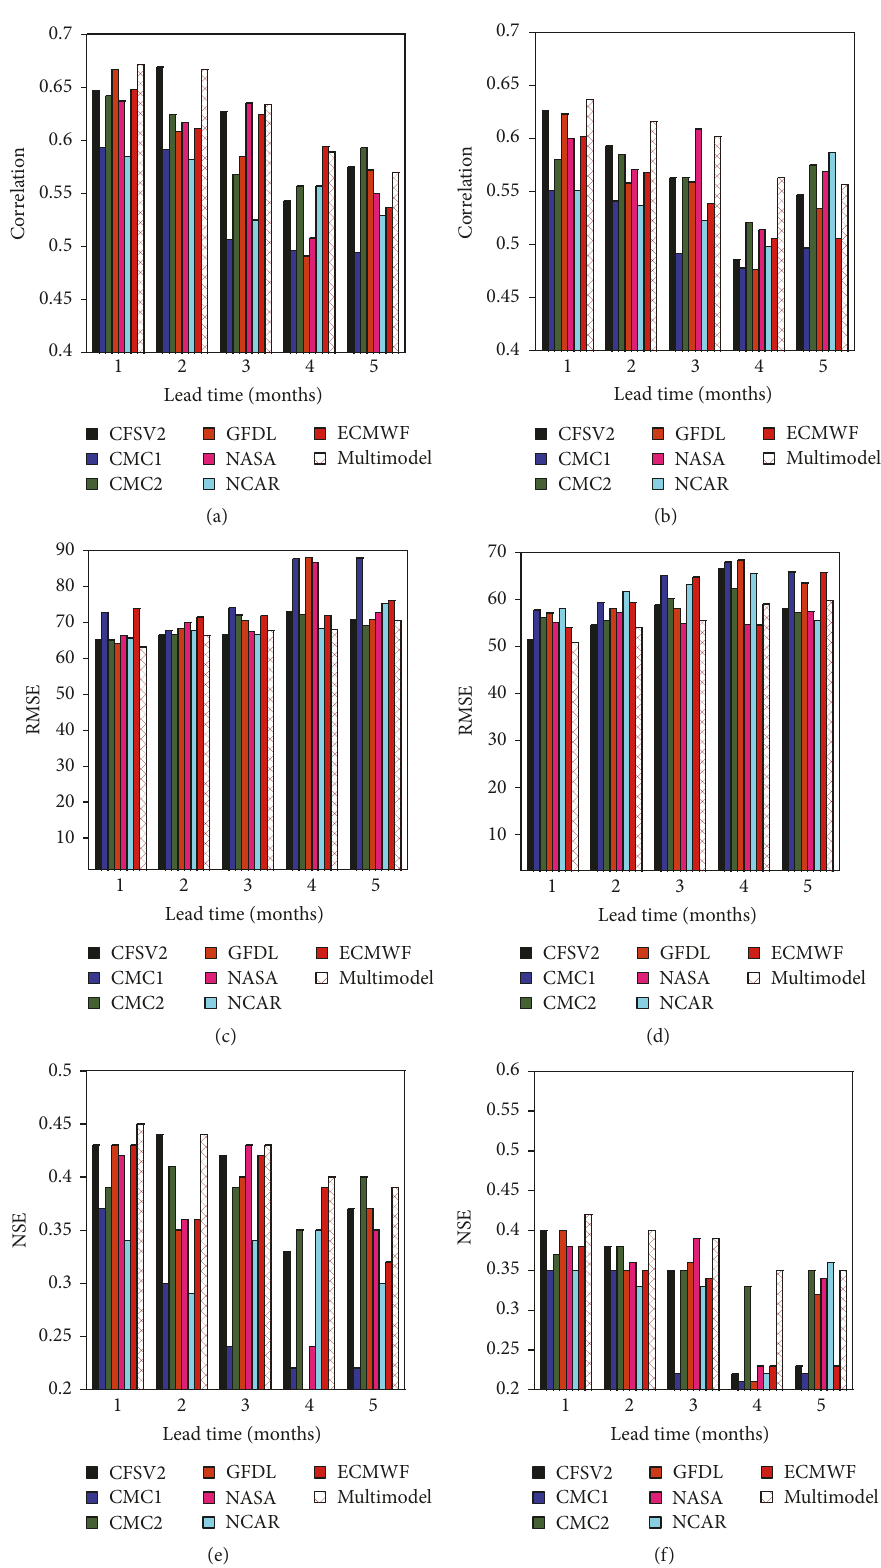
Figure 2: The correlation, RMSE, and NSE for 1–5 months’ lead times for each individual model and the IMME ensemble at the northern (a, c, e) and central (b, d, f) parts of the